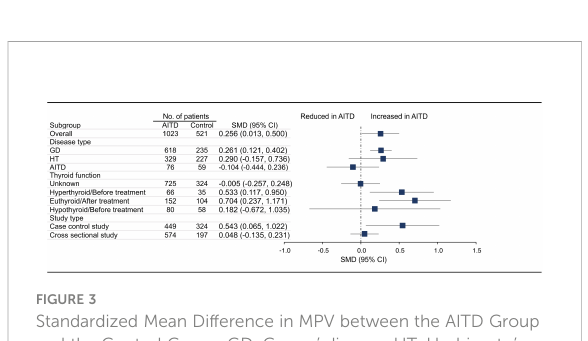
FIGURE 3 Standardized Mean Difference in MPV between the AITD Group and the Control Group. GD, Graves ’ disease; HT, Hashimoto ’ s thyroiditis; AITD, autoimmune thyroid disease; MPV, mean platelet volume; SMD, standardized mean difference; 95%CI, 95% con fi dence interval.